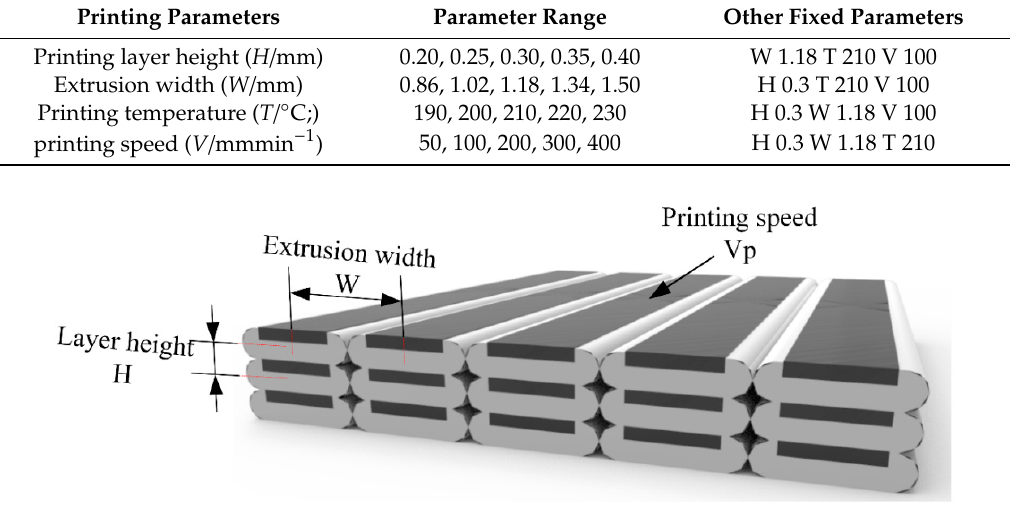
Figure 7. Sketch of 3D printing parameters.